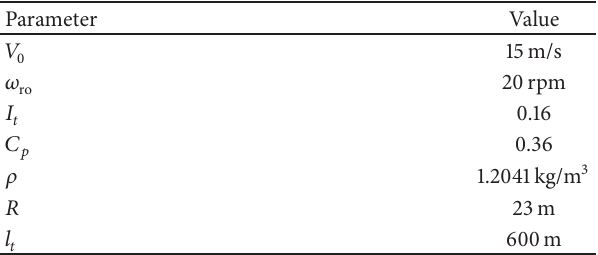
Table 2: Parameters of the turbine and the